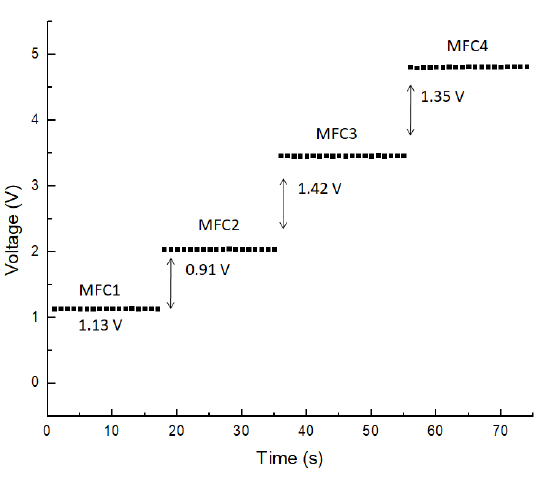
Figure 4. MFCs 1, 2, 3 and 4 being connected to the BERS one by one.